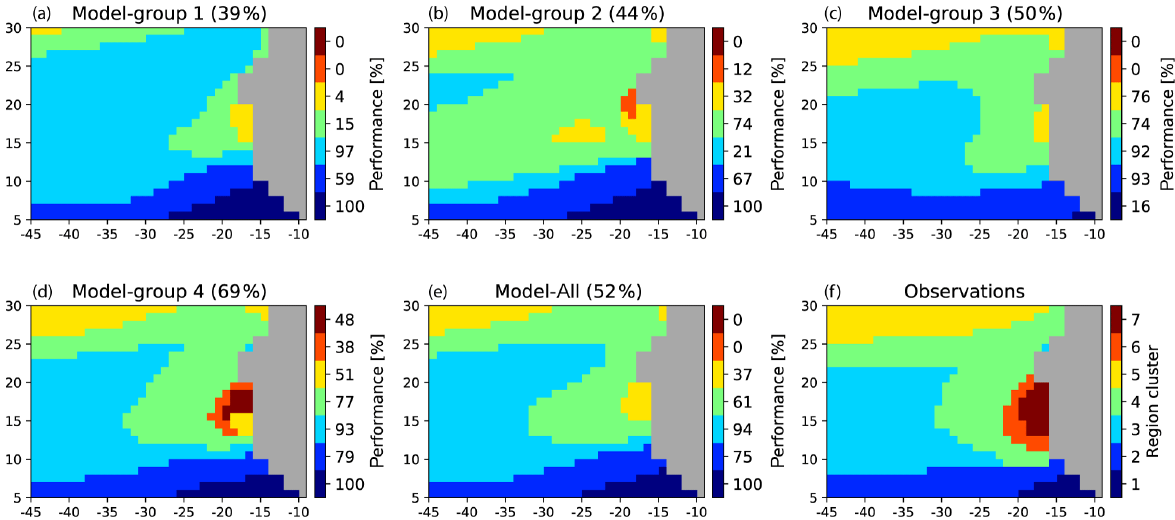
Figure 6. (a–d) Projection of the multi-model ensembles (model group) onto the SOM learned with ERSSTv3b climatology in the extended zone. Multi-model ensemble performances are obtained by averaging the skill of the models forming each group. The performances are given on top of each panel. The region clusters determined by processing the observations in the extended area and their associated colors are given in panel (f) . The color bars at the right of each multi-ensemble panel represent the skill (in %) associated with each region cluster. Panel (e) shows the projection for the full multi-model ensemble. Panel (f) reproduces the region clusters based on the observations also shown in Fig.